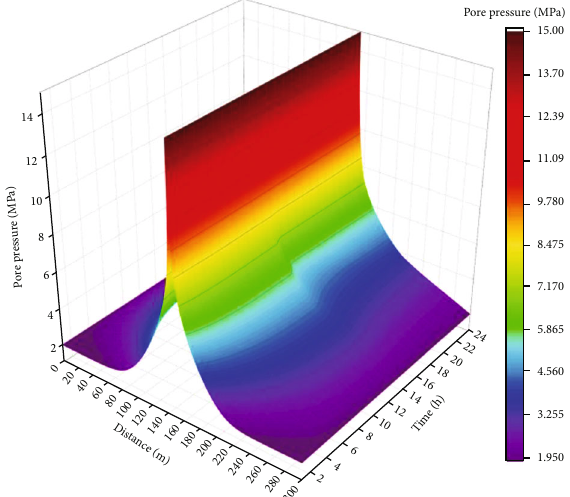
Figure 13: Time-dependent pore pressures under water-air alternating